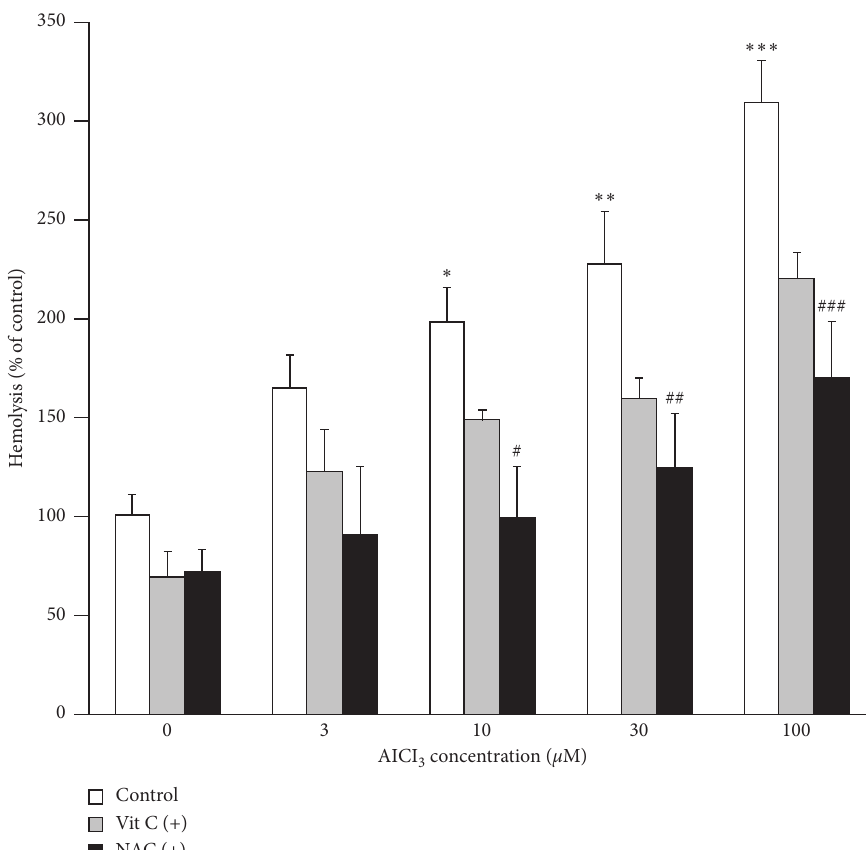
Figure 2: Effect of vitamin C (+vit C) and n-acetyl cysteine (+NAC) on Al-induced hemolysis. AlCl manner. NAC (1mM) decreased Al-induced hemolysis while vit C (0.6mM) had no significant effects on Al-induced hemolysis. Data are mean ± SD of at least five independent experiments. Nonparametric Kruskal–Wallis was used for the statistical analyses. P < 0.05 was considered as significant statistical differences between the group. P values compared to the untreated control group ( ∗ P � 0.028, ∗∗ P � 0.002, ∗∗∗ P � 0.0001), significant differences compared to corresponding AlCl ### P �